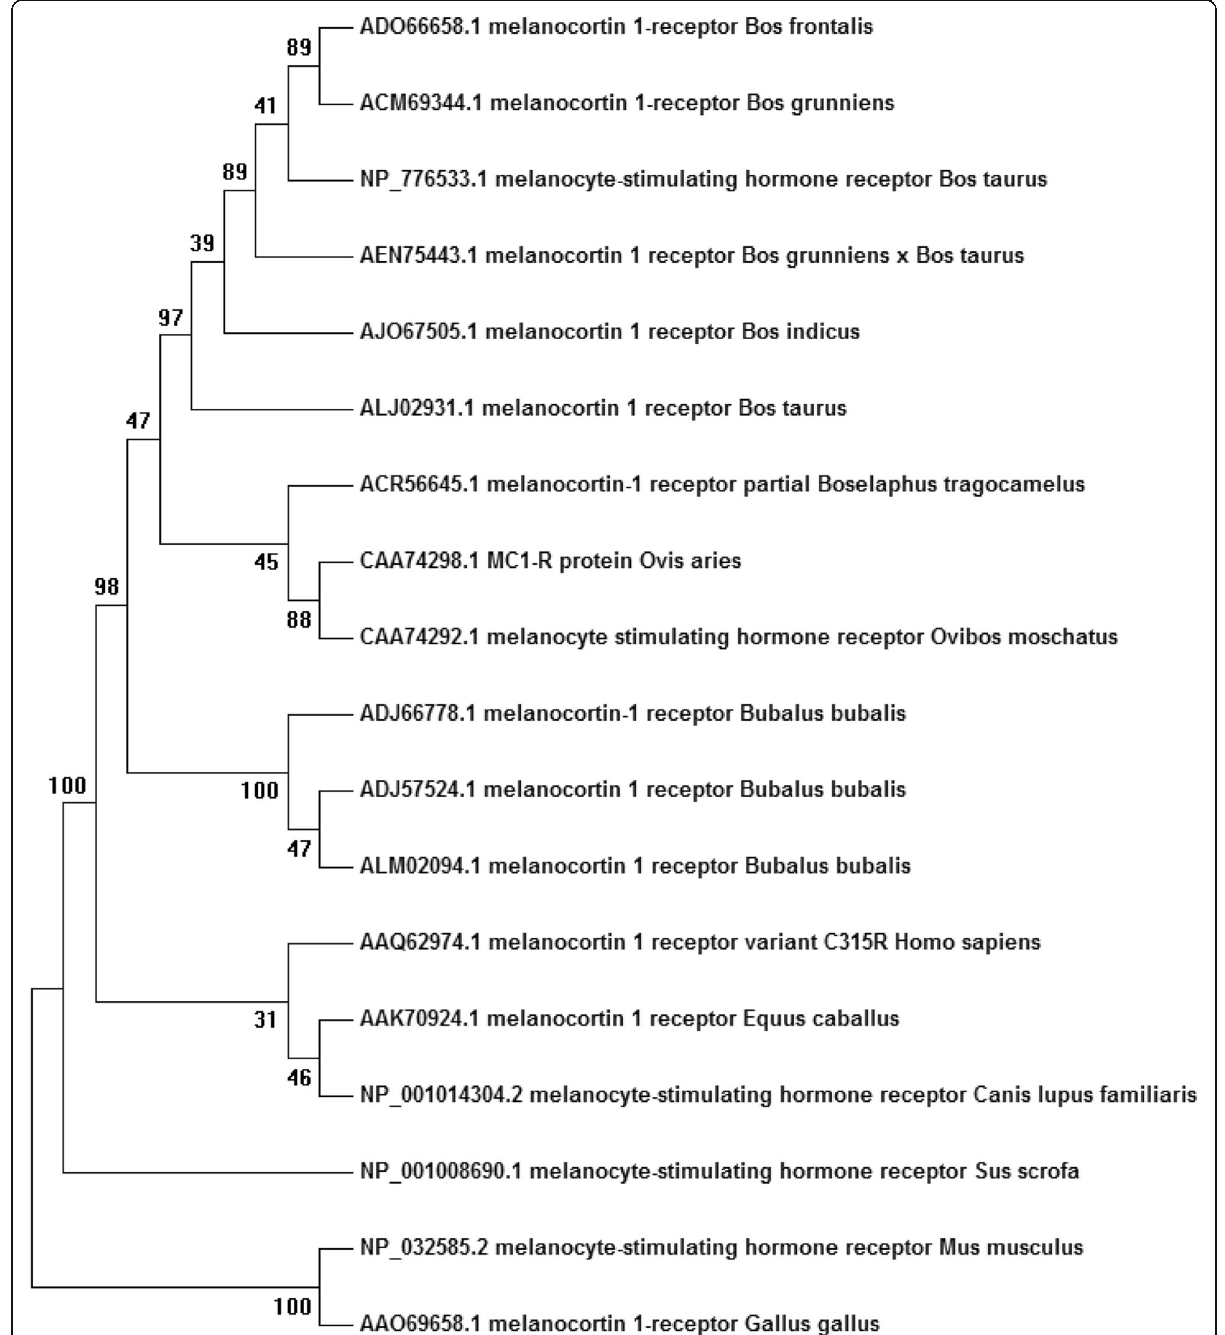
Fig. 3 Phylogenetic tree reviews based on amino acid arrays of the MC1R protein of Sahiwal ( B. indicus ). The tree was assembled by the Maximum Parsimony scheme using MEGA X (Molecular Evolutionary Genetics Analysis) software with bootstrap rates estimated for 1000